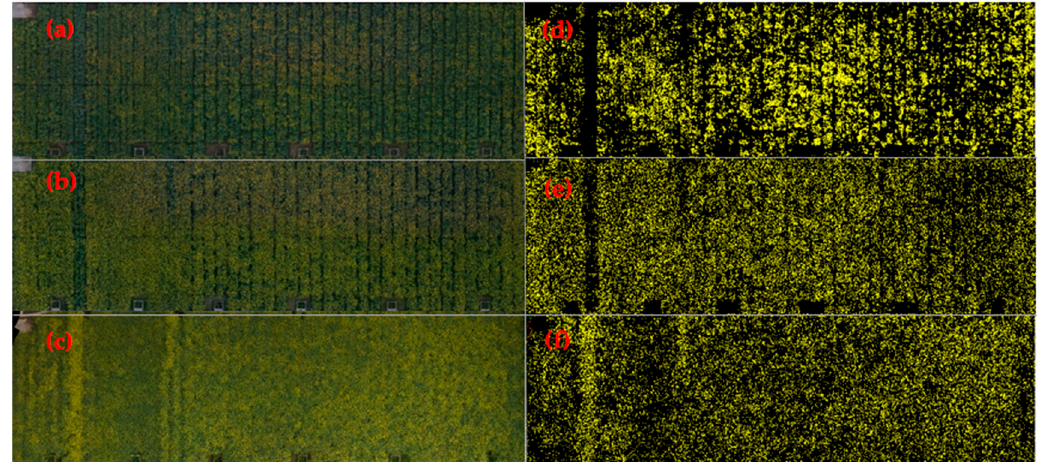
Figure 11. The flower mapping of rape fields: ( a – c ) the original Red Green Blue (RGB) image; ( d – f ) the results of image classification by the K -means algorithm based on Commission Internationale de l’Éclairage (CIE) L*a*b* space. 21 March 2017 ( a , d ); 29 March 2017 ( b , e ); 12 April 2017( c , f ).